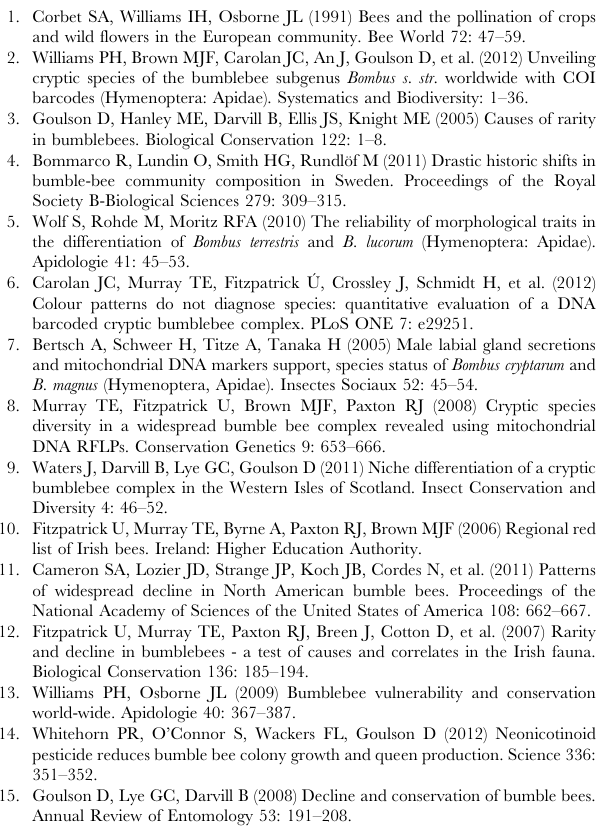
surfaces and length of field boundary. Model fit is calculated as follows: ((null deviance – residual deviance)/null deviance) [49]. Table S5 Full results of multiple comparisons of variables from generalized linear models investigating the effects of landscape composition variables on proportions and colony densities of each species. Proportion estimates are on the logit scale, and colony density estimates are on the on log scale. Model fit is calculated as follows: ((null deviance – residual deviance)/null deviance)